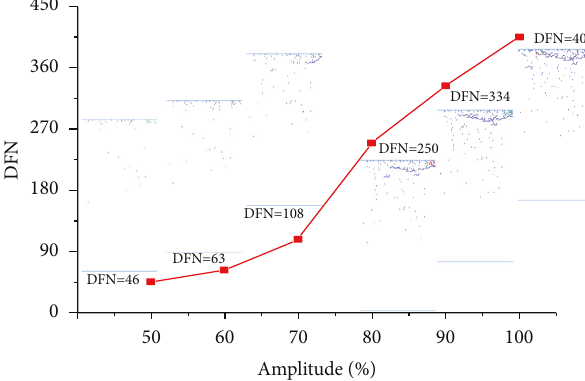
Figure 12: Discrete rift network at different